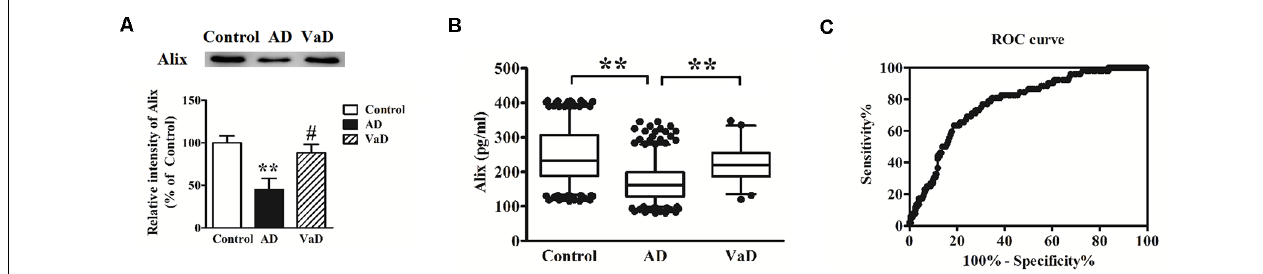
FIGURE 5 | (A) Western blot analysis of Alix in brain tissues from AD patients, vascular dementia (VaD) patients and the controls. Equal volume of each sample was loaded and β -actin was used as a loading control. Values were expressed as percentages compared to control group (set to 100%), and represented as means ± SEM. n = 12 for AD and control group, and n = 8 for VaD group. ** p < 0.01 vs. the control group, # p < 0.05 vs. AD group. (B) Scatter plots of Alix levels in serum of VaD ( n = 52), AD ( n = 404) and Controls ( n = 404) measured by ELISA. ** p < 0.01. (C) ROC curve analysis for serum Alix between VaD and AD. The AUC was 0.777.